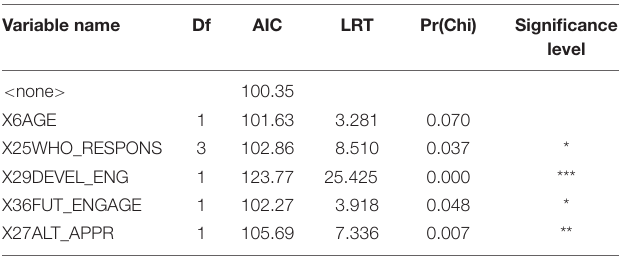
TABLE 2 | Single term deletions test for main effects for logit model to explaining marine researcher engagement with Aboriginal and/or Torres Strait Islander communities (see Table 1 for variable description).